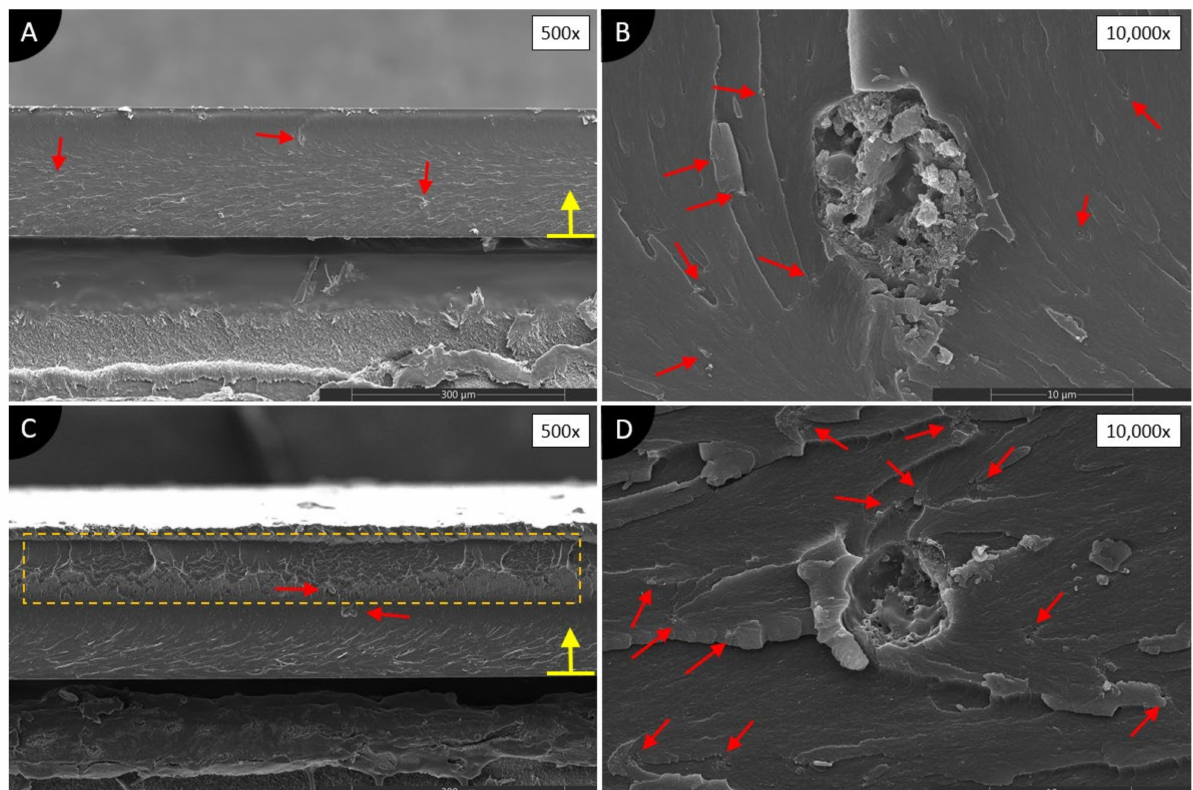
Figure 7. SEM images of cross-sections of 0.1 wt.% CB/photopolymer composites dispersed in ( A , B ) acetone; ( C , D ) isopropanol. Red, solid line arrows show agglomerations. Orange, dashed rectangular shape depicts an unknown change of the photopolymer. A yellow arrow with a line defines the direction of UV light and the surface of the composite on the glass during